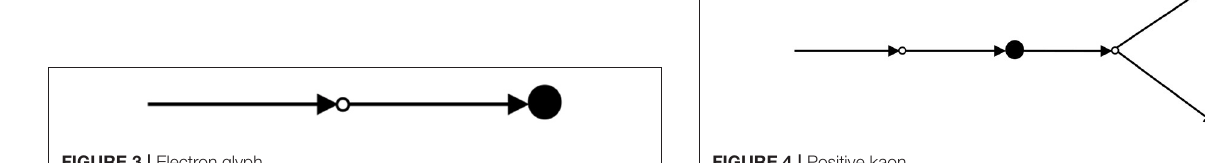
FIGURE 3 | Electron